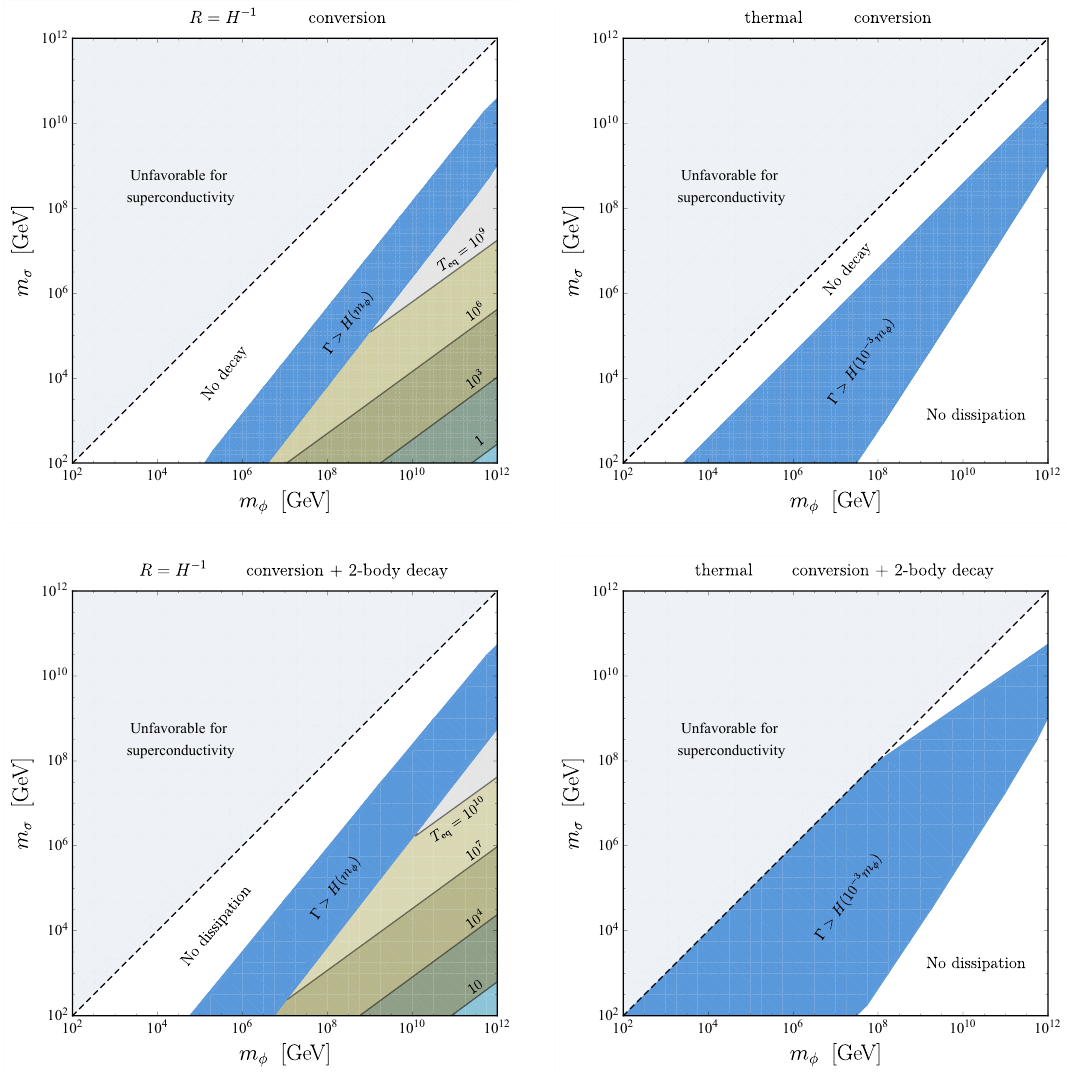
Figure 8 . The parameter space where the decay of the zero mode with E = m φ is significant, i.e., Γ( T ) > H ( T ) holds at some stage. These figures differ with respect to the type of string curves and decay processes as indicated. The contours correspond to the GeV-unit values of the temperature T at which the transition from Γ < H to Γ > H occurs. The blue regions means Γ > H is already met at the stage of the production of string network. The white blank regions represent the parameter space in which the zero mode survives at all stages, i.e., Γ < H for arbitrary